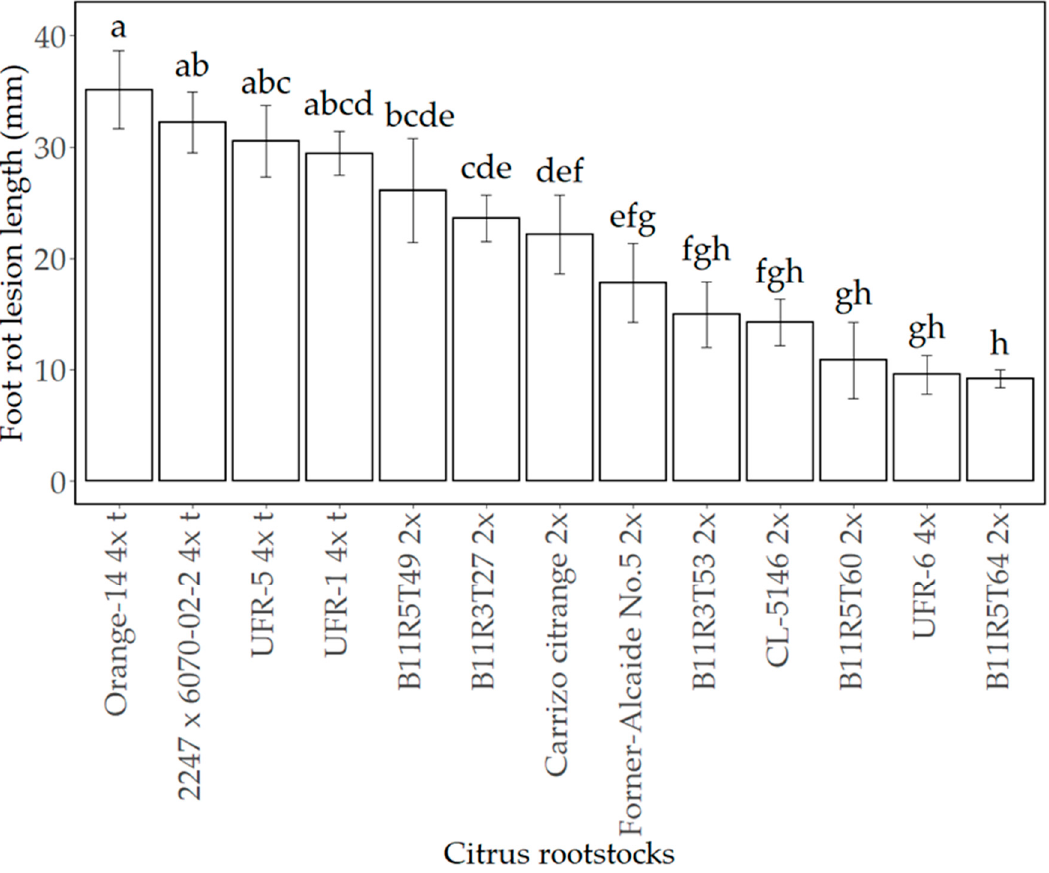
Figure 4. Mean foot rot lesion length response caused by P. nicotianae on thirteen different citrus rootstocks tested during spring of 2021. Different letters above the bars indicate significant differences among the citrus rootstocks assayed ( p < 0.05). Ploidy: 2x; 4x; 4x t: 4x tetrazyg.